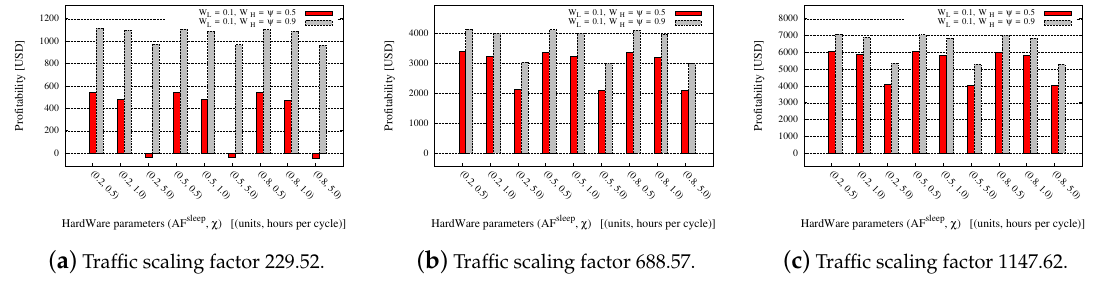
Figure 12. Profitability R total after 14 days vs. the HW parameters with | T low | = 72, | T inc | =